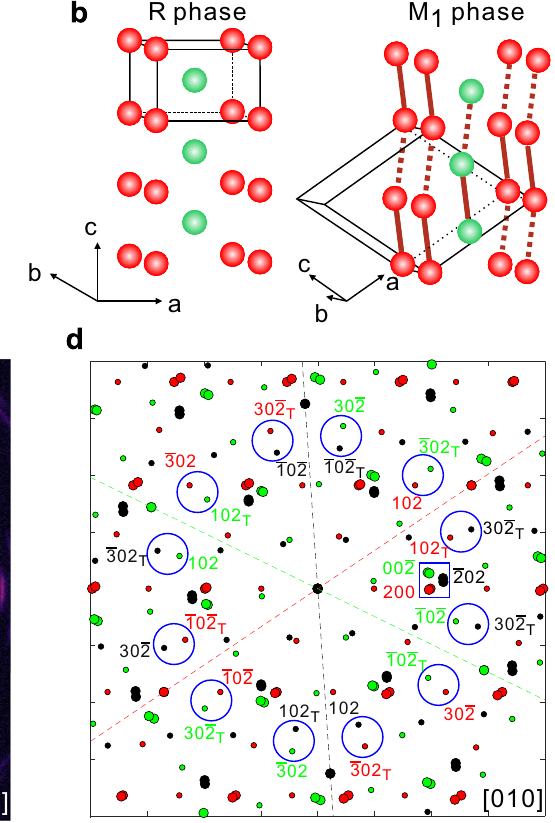
from STO spots by white circles. There are two spots in each group. IndexedinFig.1d,theinner12spotsare102 = 102 T =